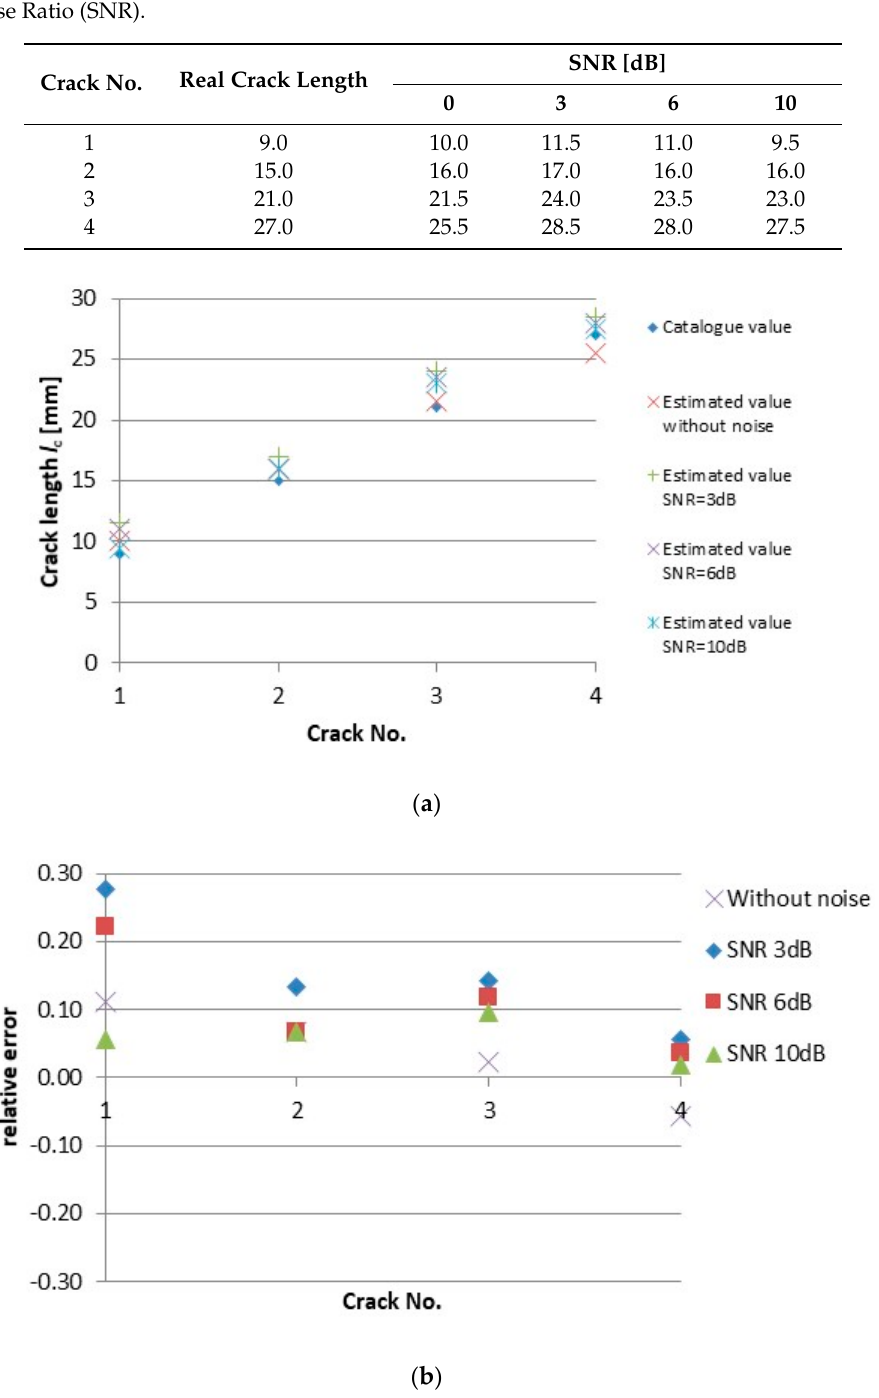
Figure 8. Results of the crack length l c reconstruction from the ECT responses with different SRN: ( a ) estimated absolute values; ( b ) relative error of estimation. ( a ) estimated absolute values; ( b ) relative error of